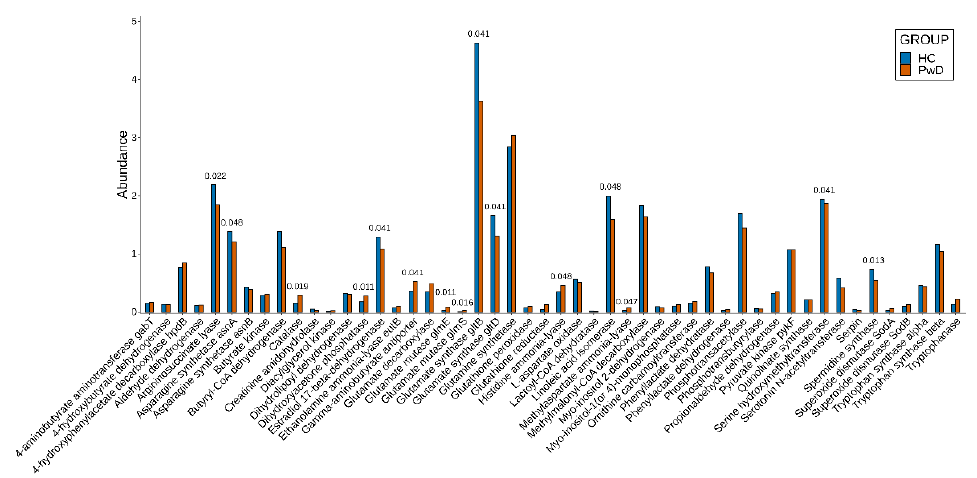
Figure 3. Changes in abundances of the genes in the PwD and HC groups. Only genes identified in more than half of the samples are shown on the graph. The values above the bars indicate the FDR-corrected p -values for genes with statistically significant differences in abundances.